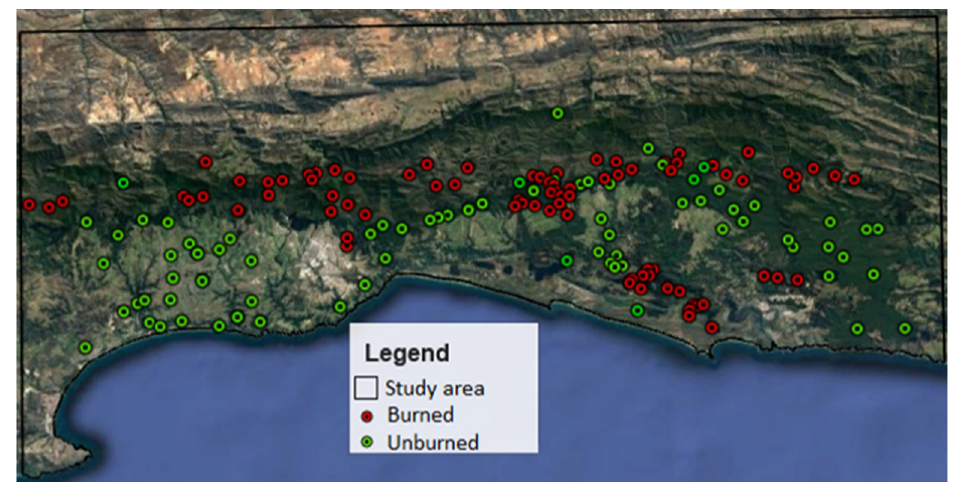
Figure 2. Spatial distribution of samples for burned and unburned areas.